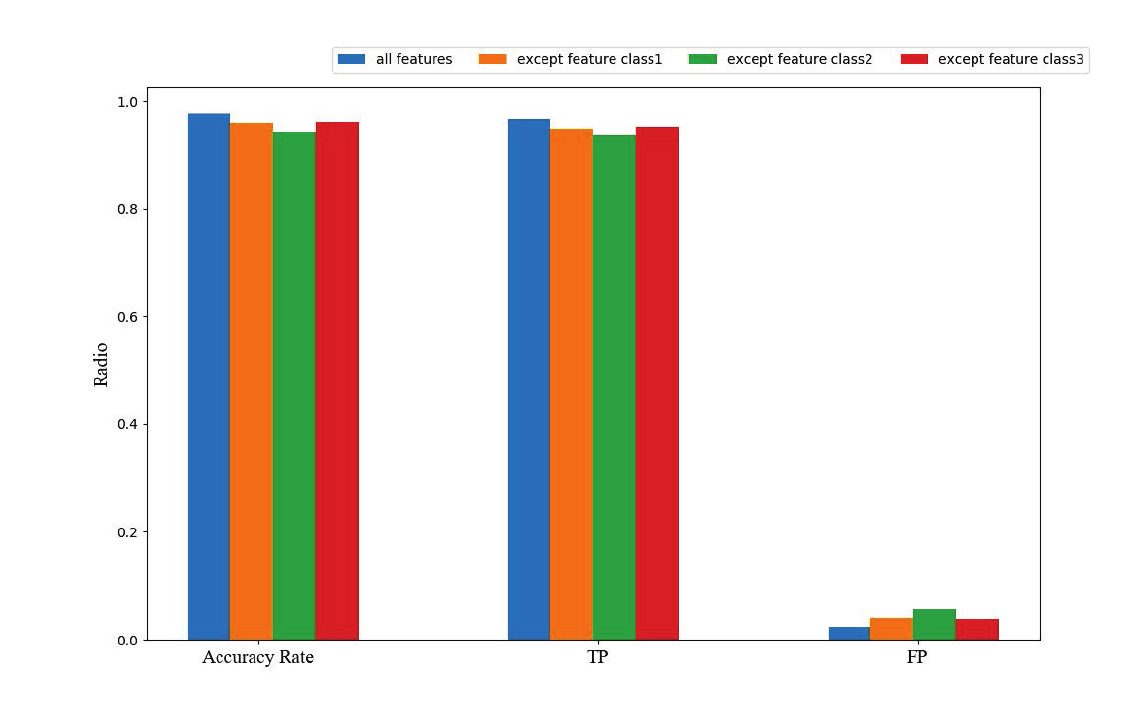
Figure 6. Different feature sets comparison result on Accuracy Rate, true positive (TP), and false positive